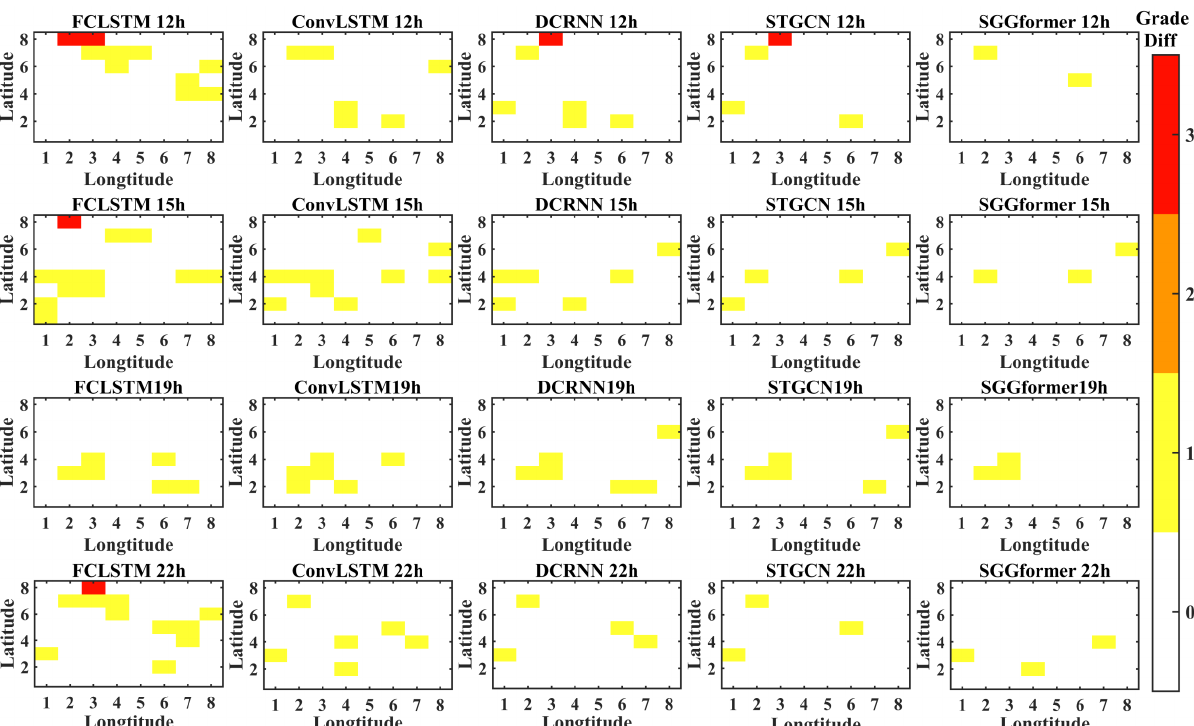
Figure 12. The grade difference under prediction length 3